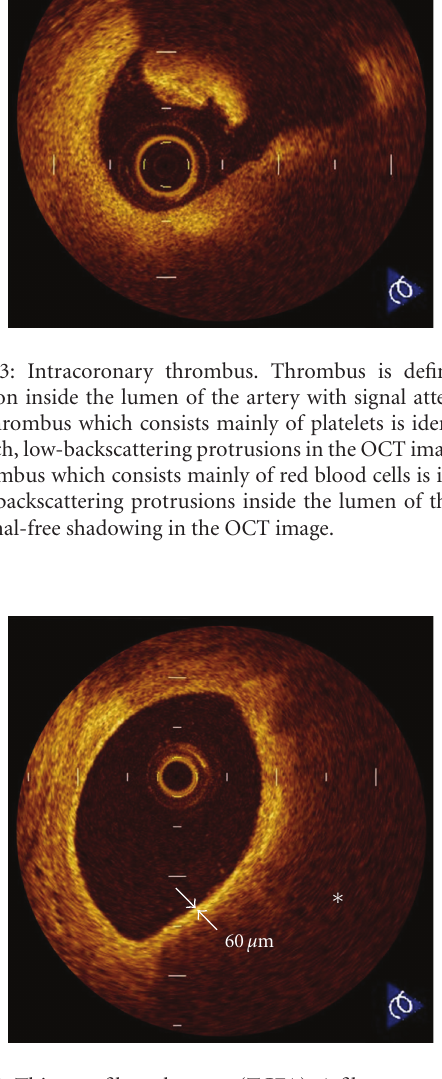
Figure 4: Thin-cap fibroatheroma (TCFA). A fibrous cap (arrows) is identified as a signal-rich homogenous region overlying a lipid core ( ∗ ), which is characterized by a signal-poor region. TCFA is defined as a plaque with a fibrous cap measuring < 65 μ m. OCT- detected TCFAs are often observed in the culprit lesions of acute coronary